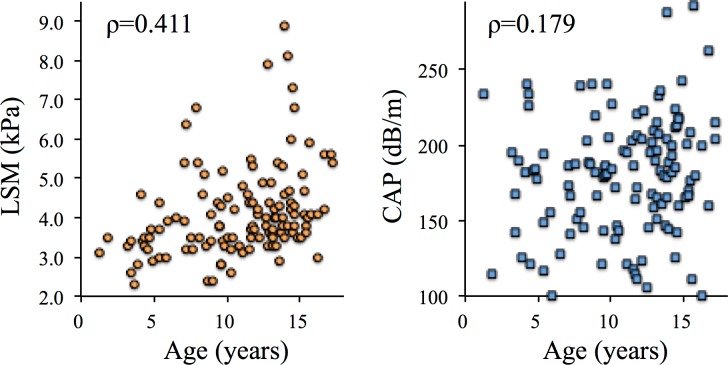
Distributions of liver stiffness measurement (LSM; left) and controlled attenuation parameter (CAP; right) values with age.LSM was positively correlated with age (ρ = 0.411), whereas CAP was not (ρ = 0.179). Correlations between age and LSM or CAP were evaluated by using Spearman’ s rank correlation coefficient (ρ). Spearman’s ρ values >0.4 were considered indicative of a positive correlation.